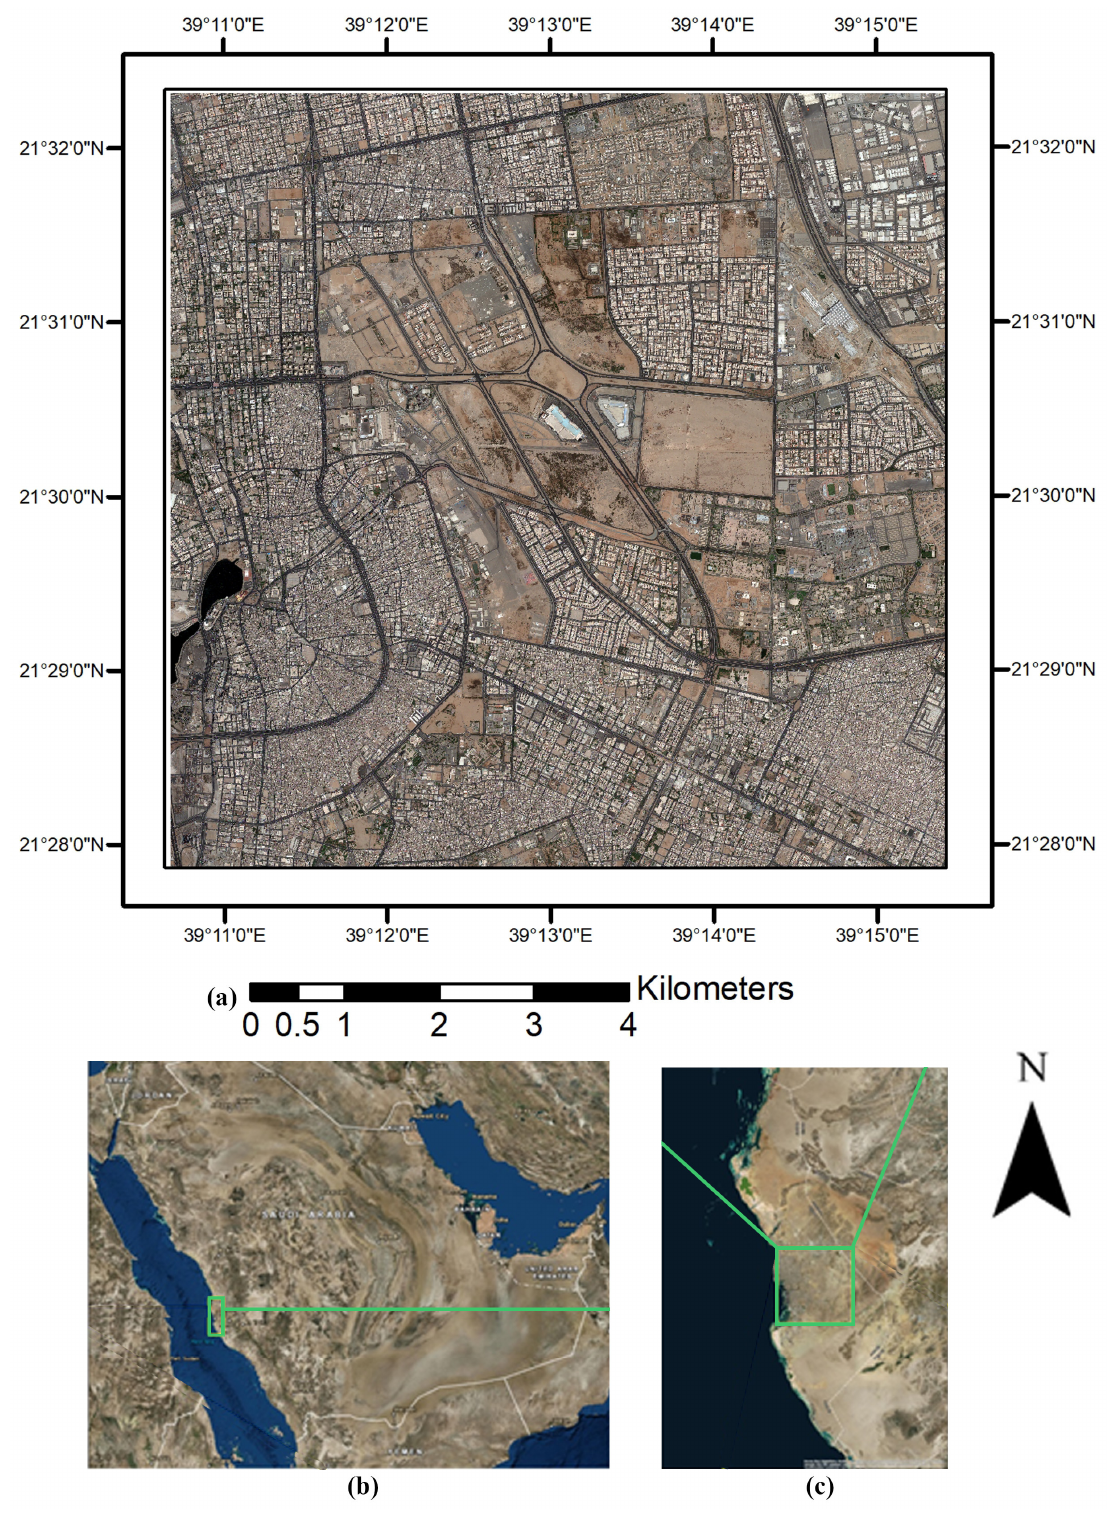
Figure 2. ( a ) The case study area investigated in this work; ( b ) Jeddah, a geographic region of Saudi Arabia (image courtesy of Google Earth); ( c ) the green rectangle displays the case study’s extent.